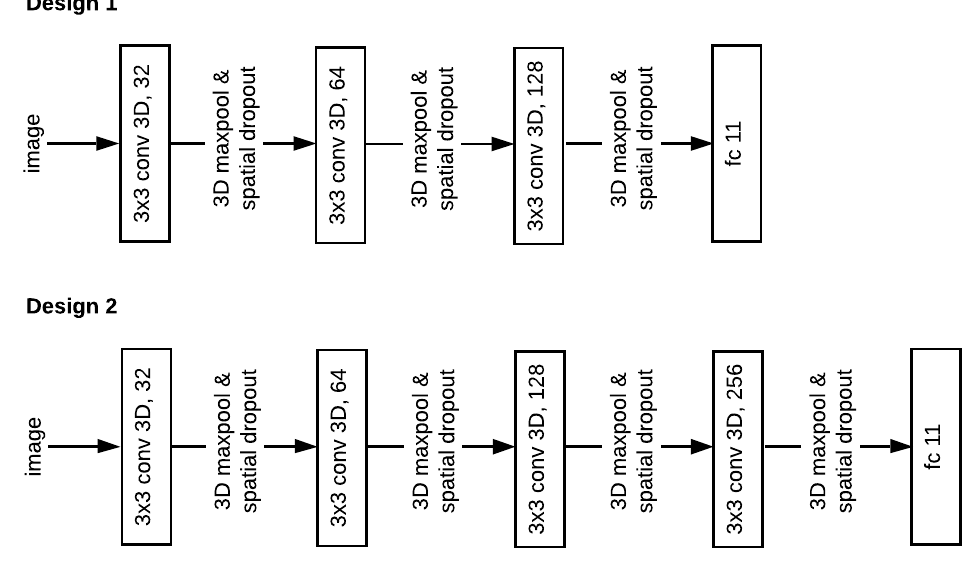
Figure A1. The evolution of Conv3D model architecture from Design 1 to final Design